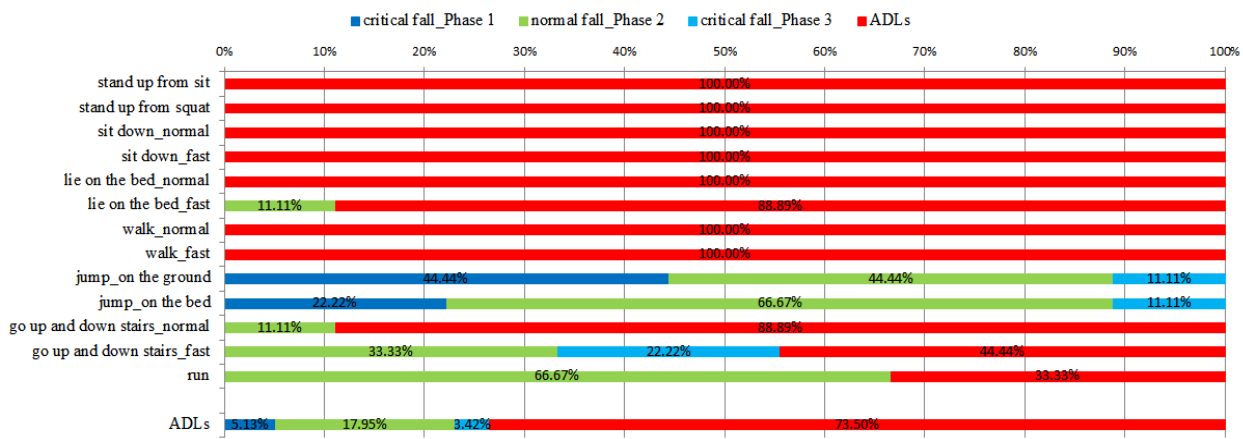
Figure 6. The detection results of ADLs using the proposed fall detection